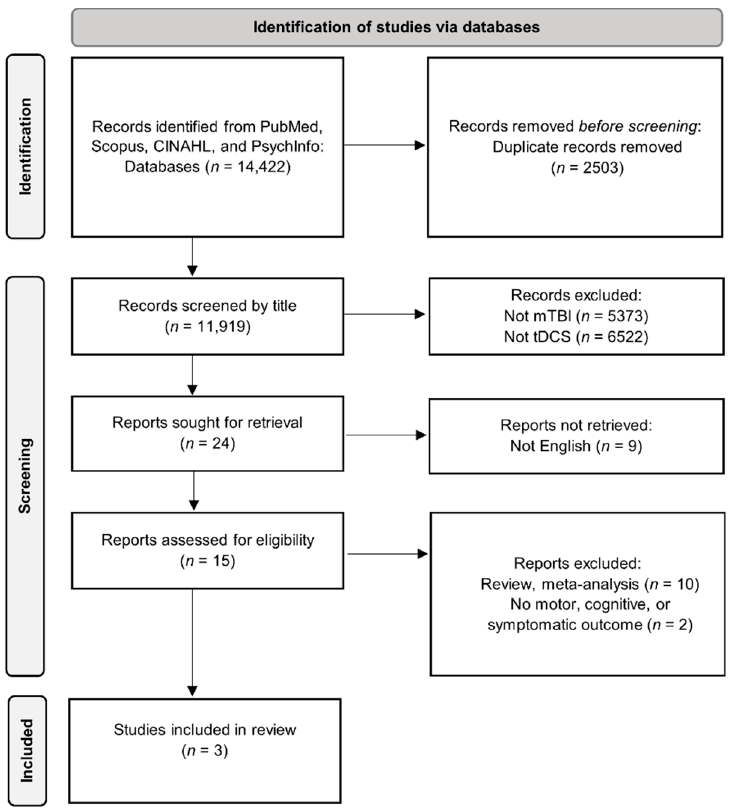
Figure 1. PRISMA flow chart of the literature search, screening, and study inclusion. Quinn, et al. [71] investigated whether anodal tDCS over the left dorsolateral prefrontal cortex (DLPFC) plus cognitive training altered cerebral blood flow (CBF) on pseudocontin- uous arterial spin-labeling (pCASL) sequences in mTBI patients. Twenty-four subjects (15 male) with chronic mTBI with cognitive persistent post-traumatic symptoms were